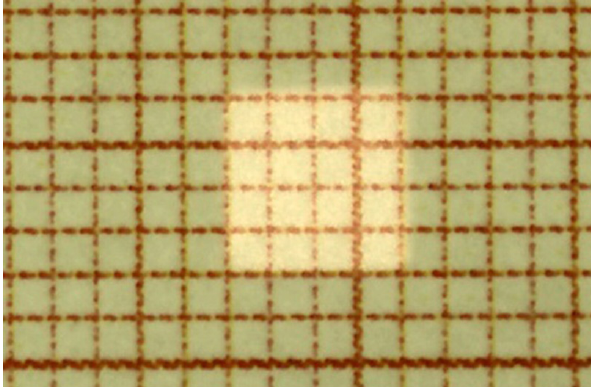
Figure 3. Excitation spot generated with AO1 at the sample plane. The pitch of the scaled paper is